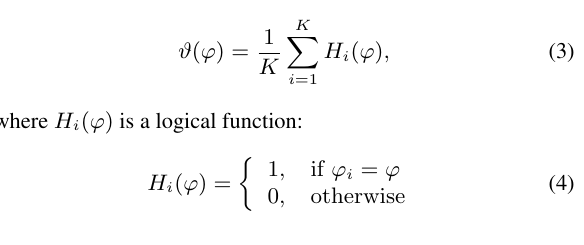
Figure 1: Correlating increasing number of bimodal Mixture of Gaussians (MGs) with the ϑ orientation density function (marked in blue). The measured α q and CP q parameters are represented for each step. The third component is found to be insignificant, as it covers only 18 MHEC points. Therefore the estimated number of main orientations is q = 2